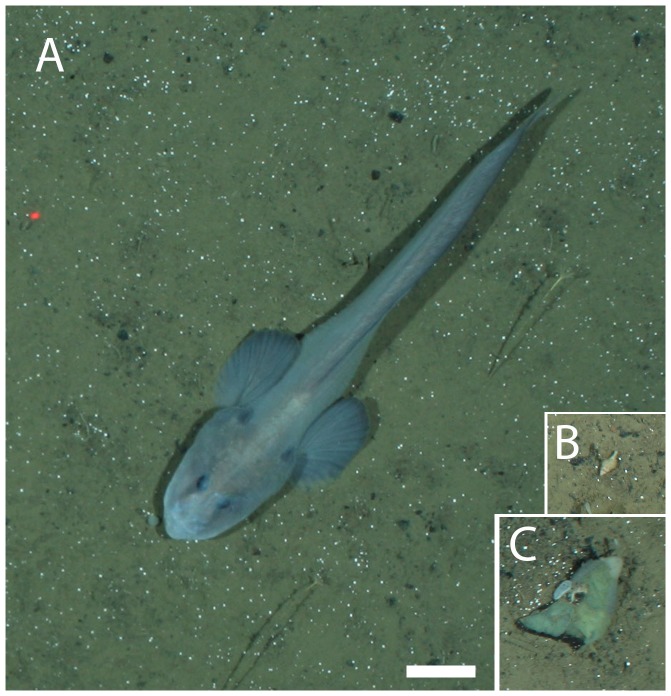
Miscellaneous taxa observed at the deep reef.A, Lycodes frigidus; B, Mohnia mohnia; C, laminar bryozoan. Scale bar  = 5 cm.